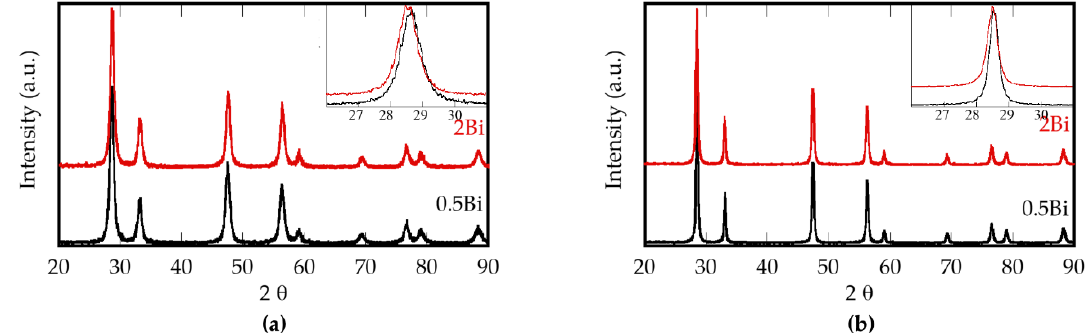
Figure 2. ( a ) Diffraction patterns of samples calcined at 600 °C for 2 h; ( b ) diffraction patterns of samples calcined at 700 °C for 100 h (insets showing magnifications of the spectra main peak).